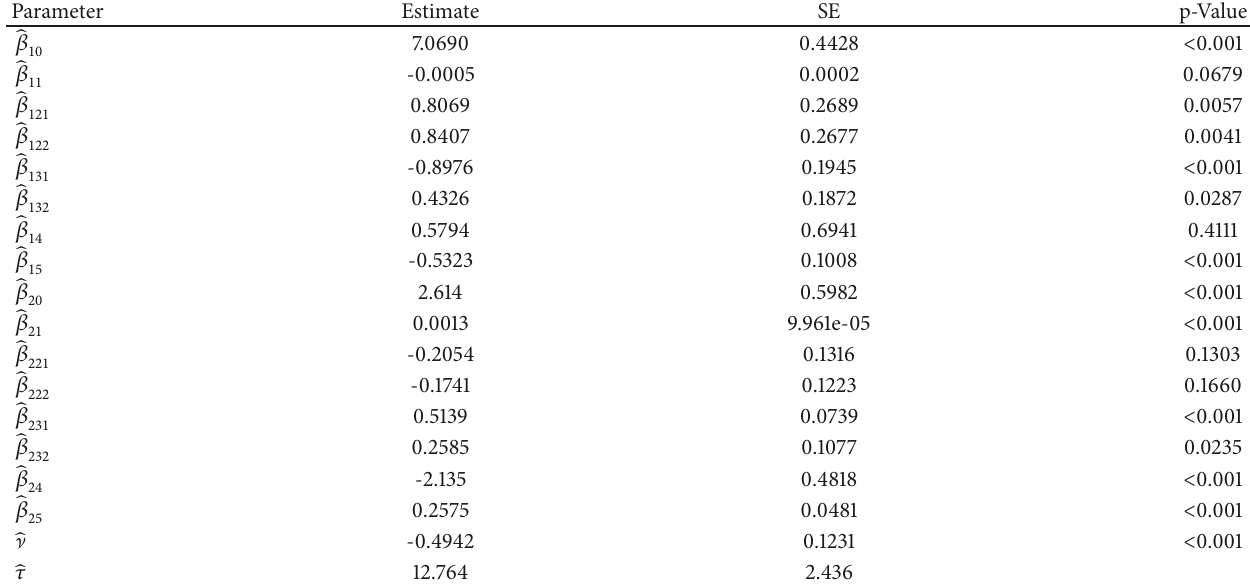
Table 8: MLEs, standard errors (SEs), and p-values for the OLLGIG regression model fitted for the price of urban property data.